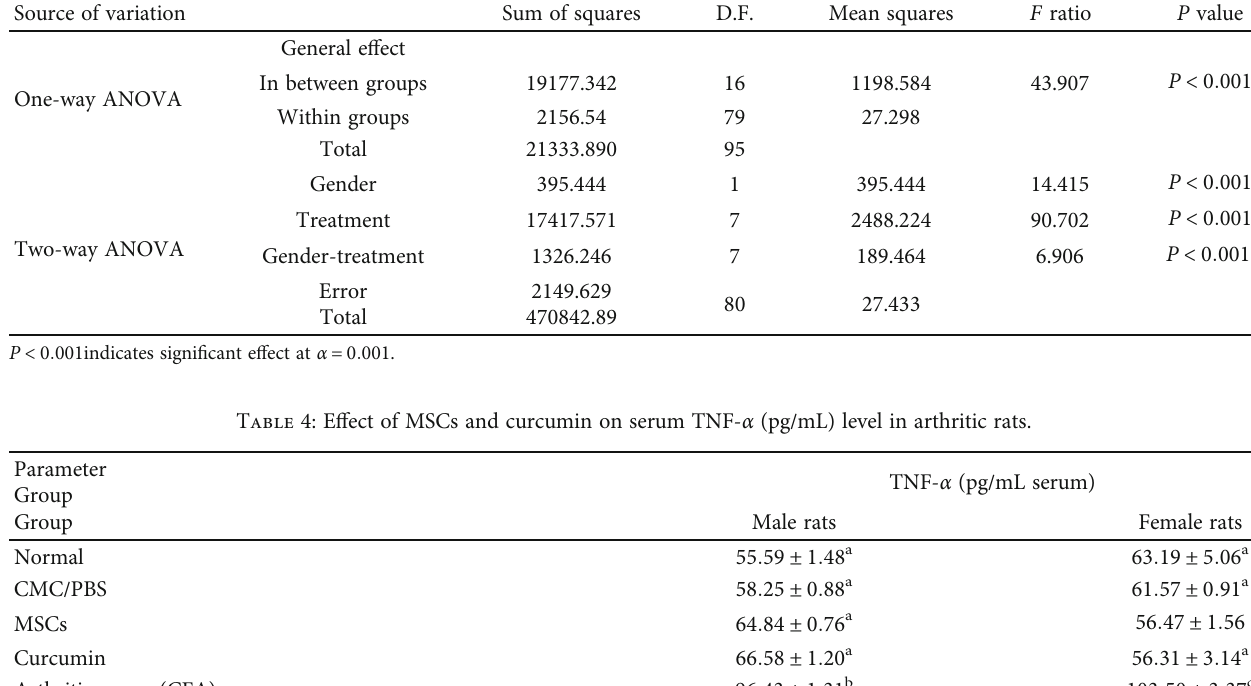
Table 3: One-way and two-way analysis for serum TNF- α (pg/mL) level in normal, arthritic, and arthritic-treated rats. Source of variation Sum of squares